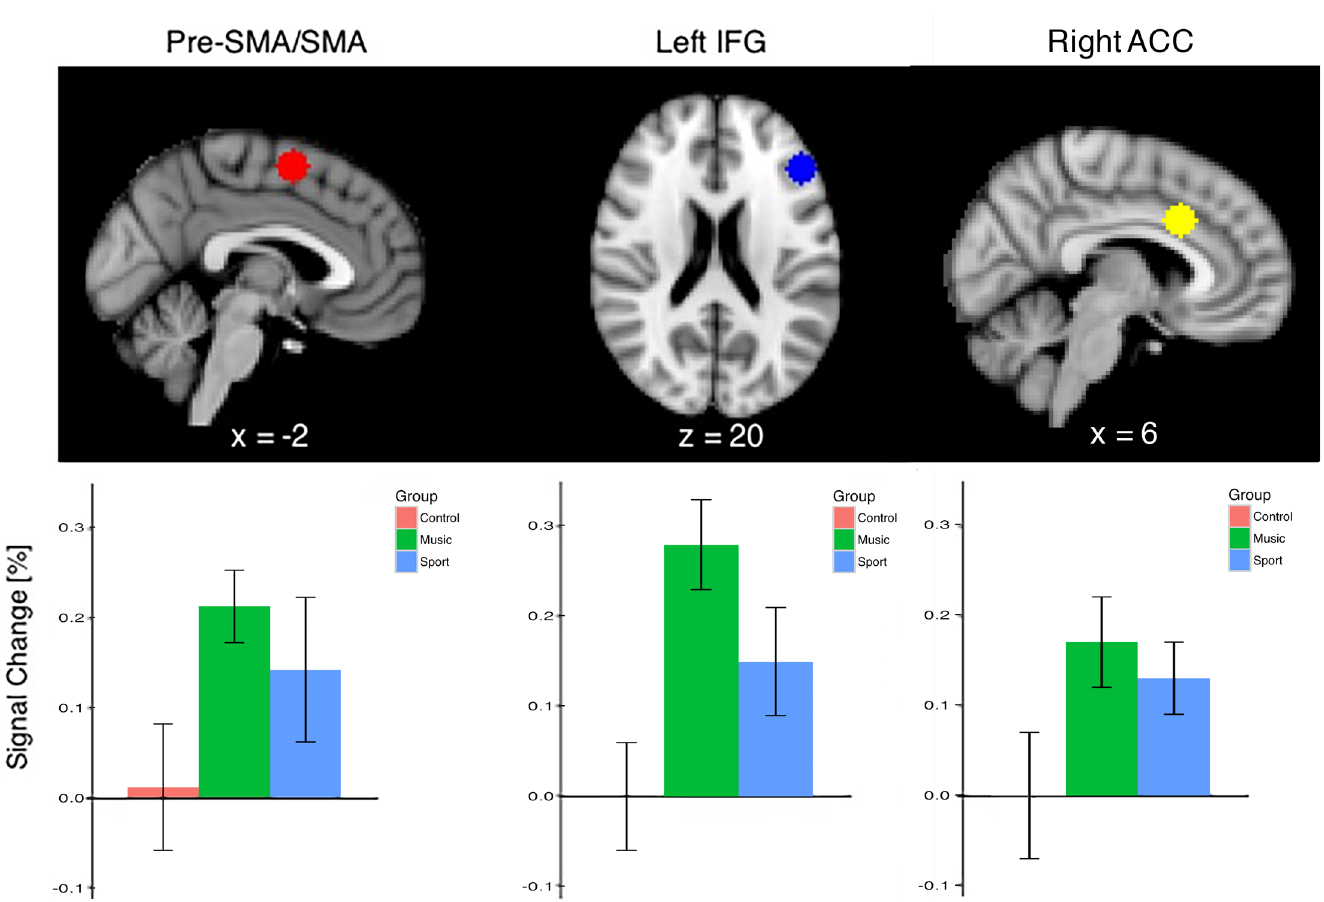
Fig 6. Percent signal change in the pre-SMA/SMA, left IFG and right ACC for the incongruent > congruent contrast during the Color-Word Stroop task by group. Regionwas definedby the peak voxel within significantclusters. Error bars representstandard error.